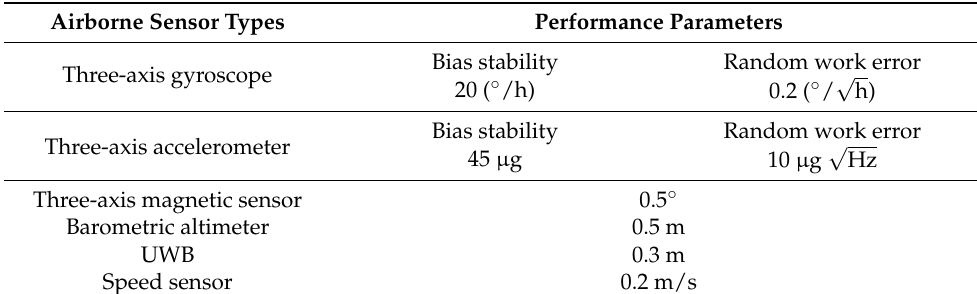
Figure 6. Two UAVs autonomous flight cooperative localization experiment.